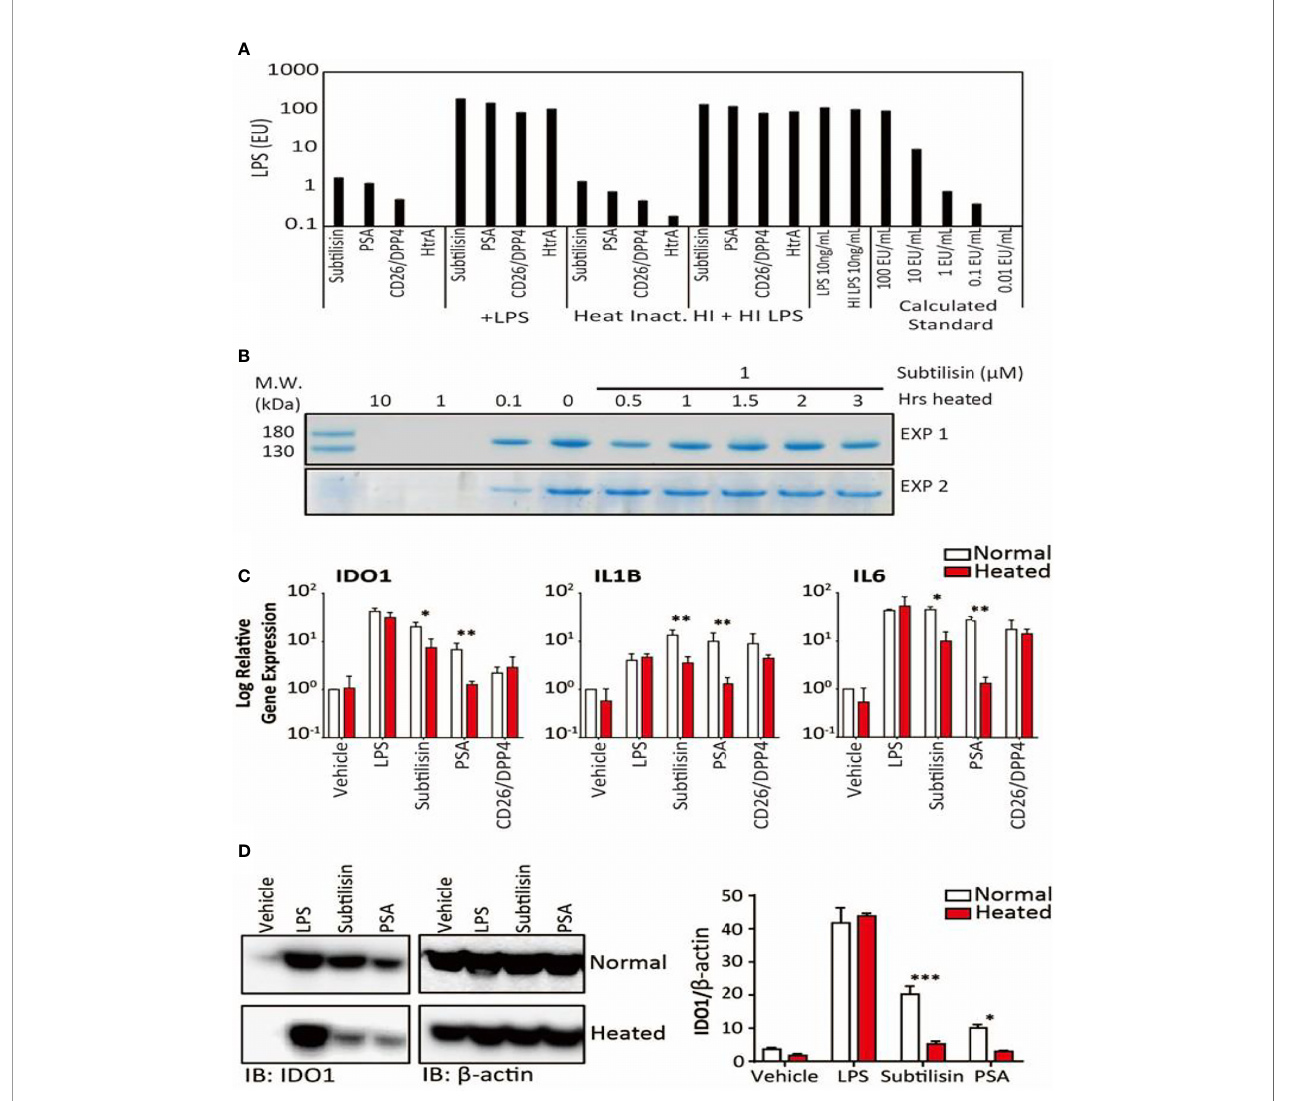
FIGURE 5 | LPS concentrations and the effects of heating on gene expression. (A) . Samples of the four active serine proteases were analysed for endotoxin contamination. In bars 1-4, when compared against LPS 10 ng/mL, subtilisin (20 nM) is associated with < 1% LPS, while PSA (100 nM), CD26/DPP4 (10 nM) and HtrA (10 nM) have even lower amounts. Bars 5-8 show that the serine proteases do not affect the LPS signal, con fi rming that they do not interfere with the assay procedure. Bars 9-12 and 13-16 reveal that heating the proteases at 70°C for 1 h did not alter the protease signals (9 – 12) or the combined protease and LPS signals (13 – 16), con fi rming that LPS was not affected by the heat treatment and was still not affected by the proteases. This conclusion is strengthened by the absence of heat on LPS alone (bars 17-18). Bars 19-23 show a calibration for the absolute concentration of LPS in this assay. (B) A Coomassie Blue stained gel of collagen in two separate experiments shows that the undigested protein in the absence of subtilisin (0 m M) is reduced at 0.1 m M and abolished at 1 and 10 m M. After heating subtilisin at 70°C for 0.5 h or longer, protease activity has been substantially reduced and is not able to degrade the collagen. (C) Quanti fi ed data for the heating experiments. Bar charts show the relative expression of genes IDO1 , IL1B and IL6 by LPS (10 ng/mL), subtilisin (20 nM), PSA (100 nM) and CD26/DPP4 (10 nM) under normal experimental conditions (open bars) and after heating at 70°C for 1 h (red/shaded bars). Heating removes much of the activity of subtilisin and PSA on all three genes. (D) Representative Western blot shows that the more heat-sensitive proteases (20 nM subtilisin and 100 nM PSA) induce less IDO1 protein when heated at 70°C for 1 h. The bar chart shows the quanti fi ed ratio of IDO1 to b -actin density. Charts show the mean ± s.e.m. (n ≧ 3 donors). *P < 0.05, **P < 0.01; ***P <